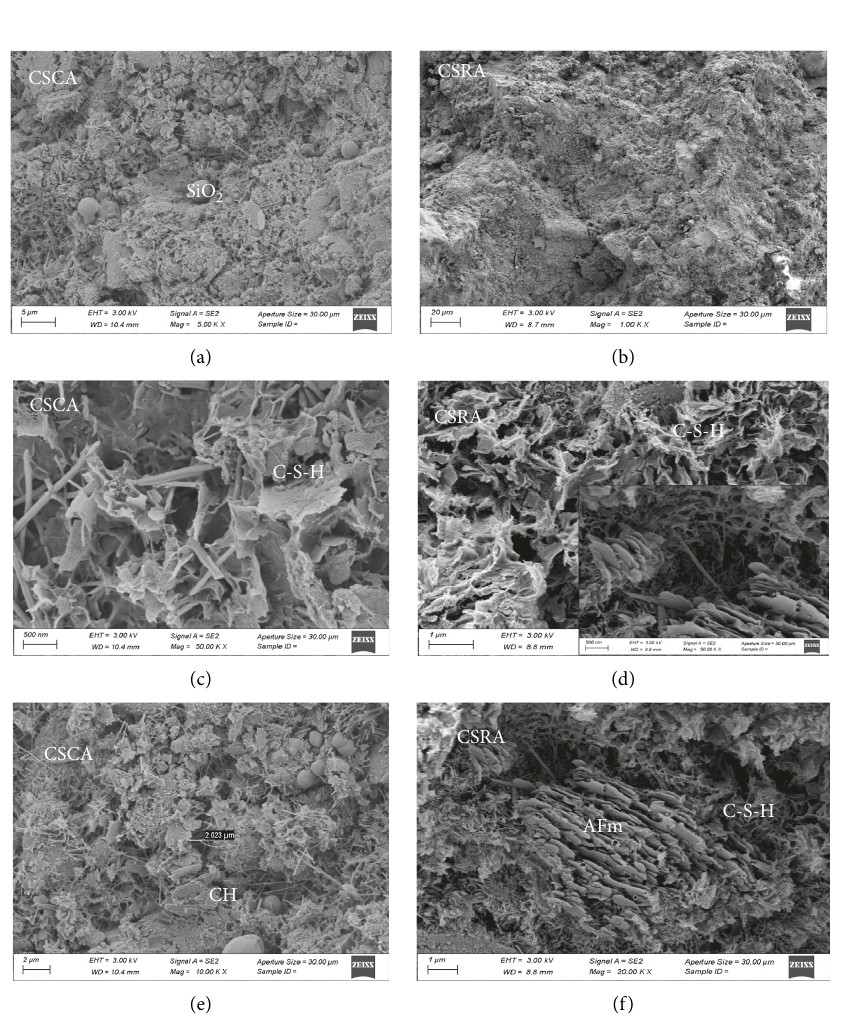
Figure 5: SEM images of distribution of hydration